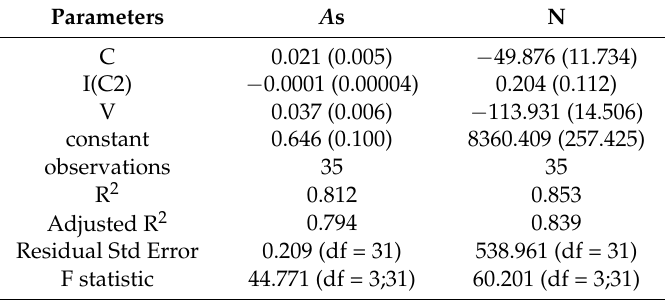
Table 2. Second-degree polynomial model parameters.